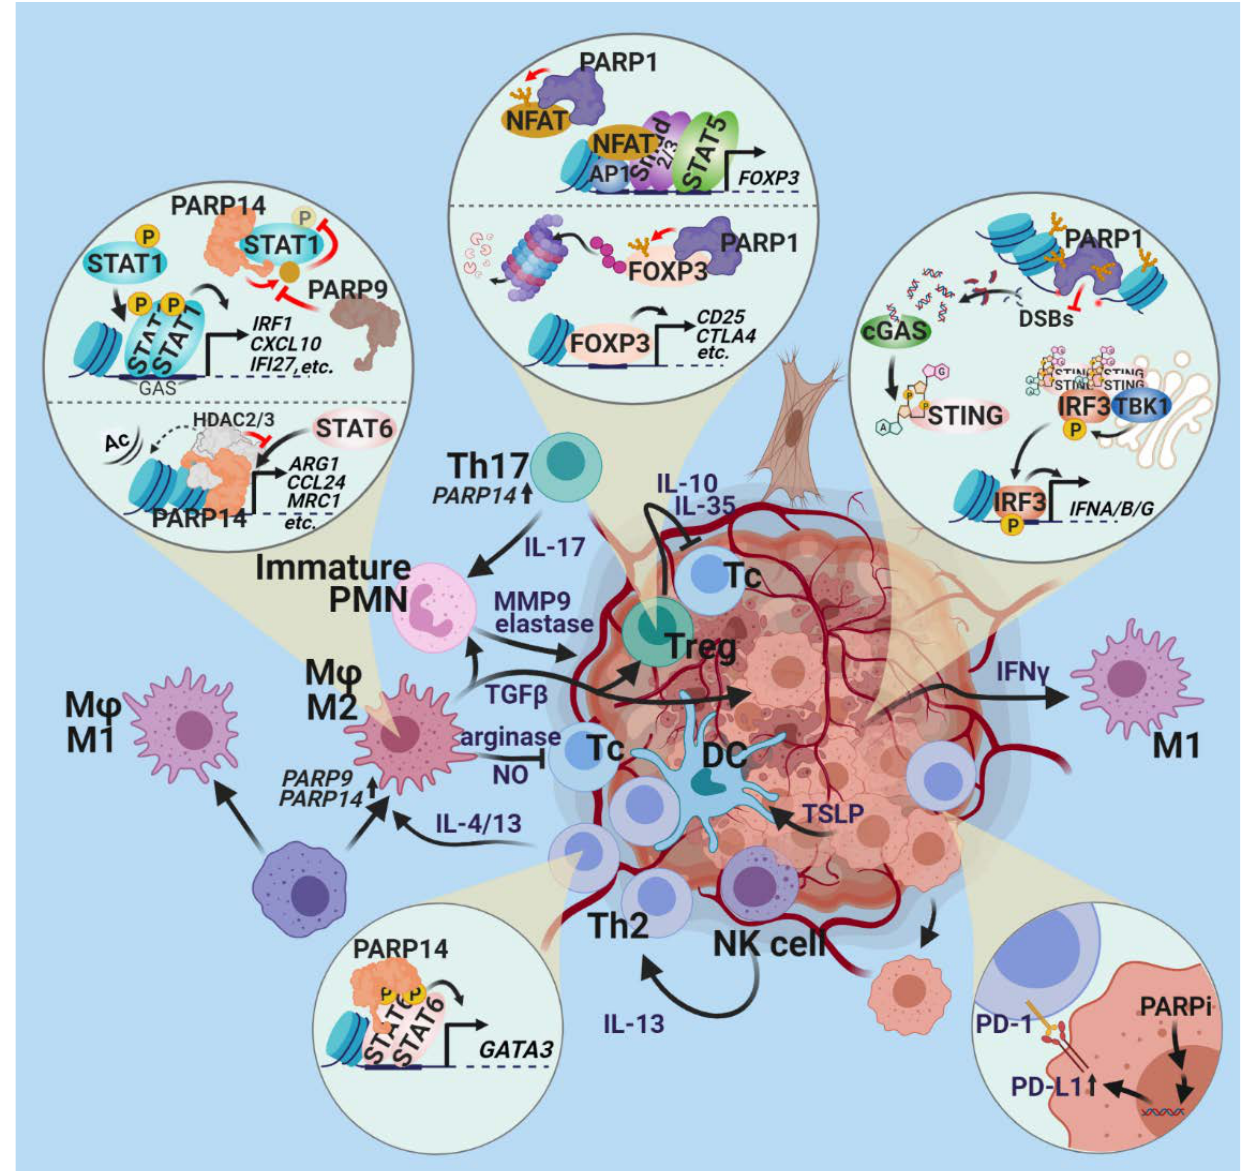
Figure 5. PARPs and tumor immune system evasion. The different PARP family members have variegated effects on the interaction of the immune system with the tumor. The development of regulatory T cells (T reg -s) is regulated by PARP1. PARP-1 PARylates nuclear factor of activated T-cells (NFAT); regulating its nuclear retention; binding to its consensus sequence; and activating genes encoding IL-2, IL-4 and and Foxp3. PARP-1 PARylates Foxp3, a master regulator of T reg development impeding the development of T reg -s. PARP-1 also controls antitumor immune responses at the level of innate immunity. In tumor cells incurring genotoxic stress, DSBs fragment the genomic DNA. The released DNA is recognized by the cytosolic innate nucleic acid sensor cGAS. Cyclic GMP–AMP produced by cGAS activates STING and IRF-mediated IFN synthesis, leading to the inflammatory polarization of macrophages. PARP-1 and -2 counteract this process by enhancing double-strand break repair (DSBR) and limiting the occurrence of DSBs. PARP-9 and PARP-14 regulate macrophage polarization. PARP-14 MARylates STAT1, leading to inhibition of STAT1 phosphorylation, whereas PARP-9 interferes with STAT1 MARylation, cross-regulating the balance of the M1/M2 polarization of macrophages. PARP-14, acting as a promoter-bound co-regulator, stimulates STAT6-mediated GATA3 expression in T cells, directing them toward a Th2 phenotype. PARP inhibition was shown to induce the expression of the immune checkpoint regulator PD-1L in